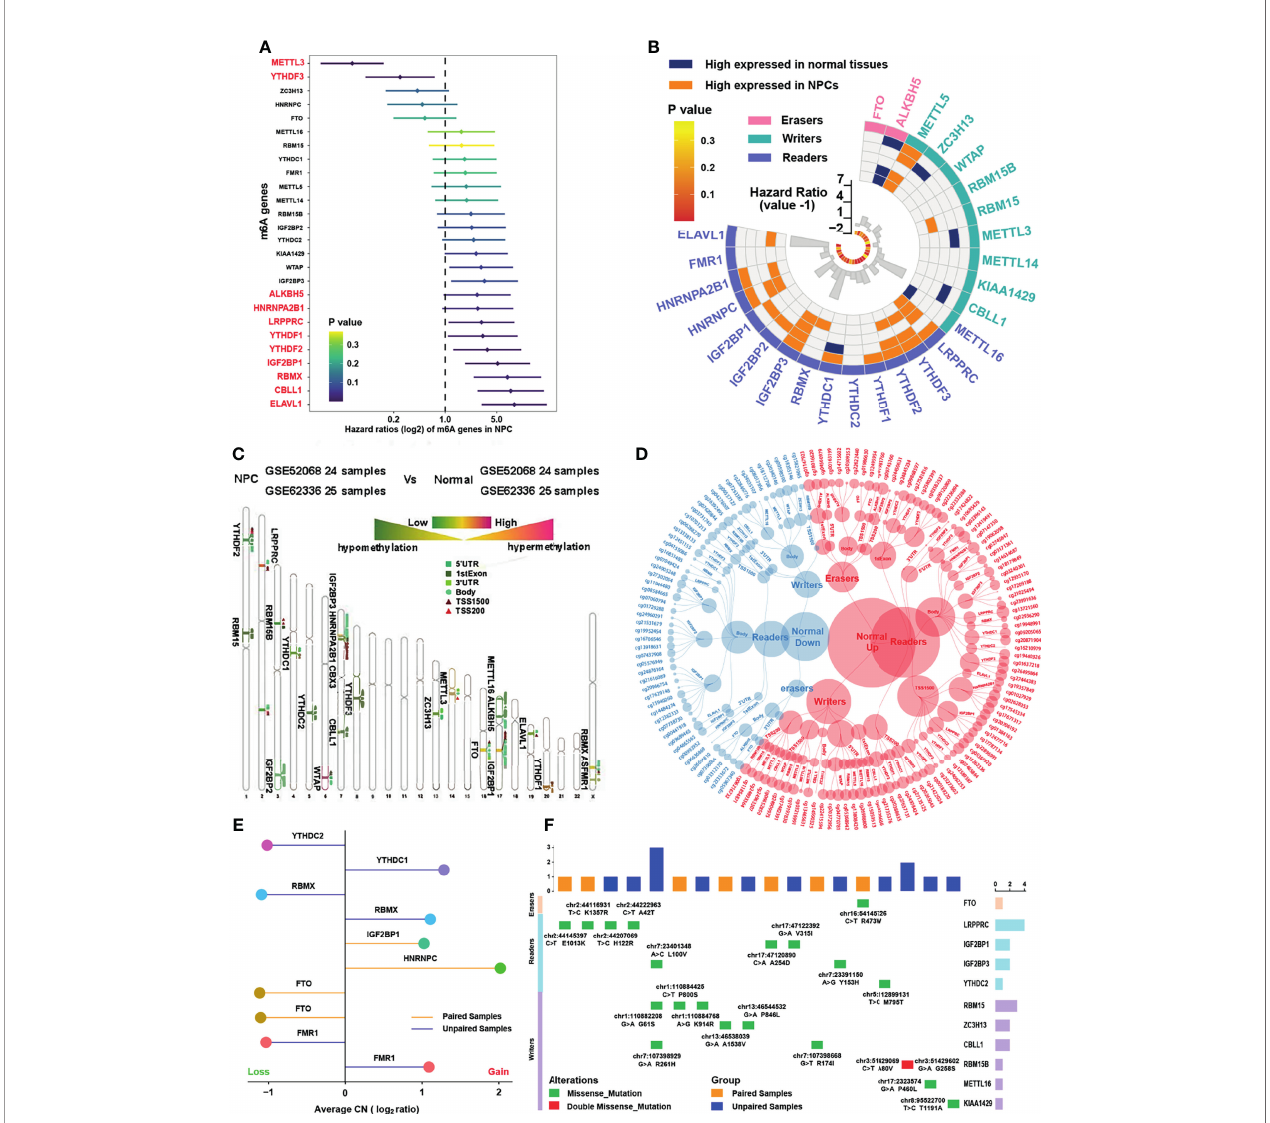
FIGURE 2 | Landscape of m6A regulators in nasopharyngeal carcinoma. (A) The prognostic analyses for 26 m6A regulators in GSE102349 cohorts, and hazard ratio >1 indicated risk factors for survival and hazard ratio <1 indicated protective factors for survival. (B) Differentially expressed m6A regulators in NPC samples compared with normal tissues in fi ve independent NPC datasets in GEO database, namely, GSE64634, GSE12452, GSE13597, GSE34573, and GSE53819. The inner columns represented HR values and P values of m6A regulators for PFS in GSE102349. (C) Average DNA methylation difference level of m6A regulators between NPC samples and normal tissues in two independent GEO datasets (GSE52068 and GSE62336). The degree to which methylation sites differ for each m6A gene was labeled on the chromosome. The darker red color indicated higher methylation and the darker green color indicated lower methylation. (D) Speci fi c DNA methylation sites of m6A regulators and the red dot represented hypermethylation in normal tissue while the blue dot represented hypermethylation in NPC. The categories of each site were also shown. (E) Copy number variation of m6A regulators in NPC in GSE102349 dataset. (F) The somatic mutations of m6A regulators in NPC in GSE102349 dataset. Paired cohort referred to samples with matched blood samples and unpaired cohort referred to tumor samples